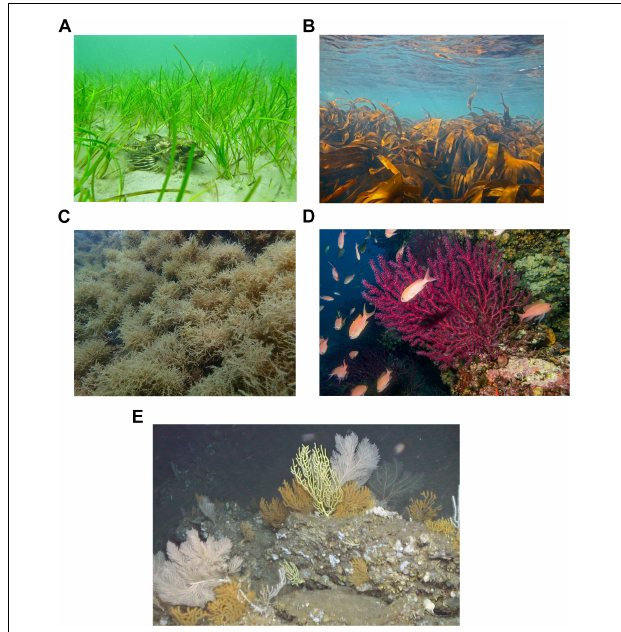
FIGURE 1 | Examples of the selected marine habitats assessed in this paper: (A) Zostera marina seagrass meadow, (B) Laminaria hyperborea kelp forest, (C) Treptacantha elegans macroalgal bed, (D) Mediterranean coralligenous assemblage, and (E) Cold-water coral habitat, dominated by the octocorals Callogorgia verticillata , Acanthogorgia sp. and Dentomuricea aff. meteor in the Azores. Photos by Christoffer Boström (A) , Janne K. Gitmark (B) , Alba Medrano (C) , Cristina Linares (D) and EMEPC, ROV Luso (EMEPC/Luso/Açores/2009) (E)